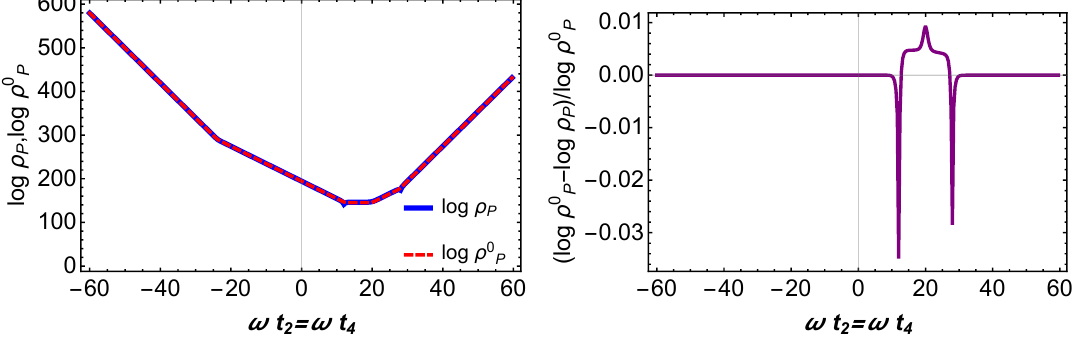
− log ρ ) / log ρ 0 L L L = 10 − 3 . ω